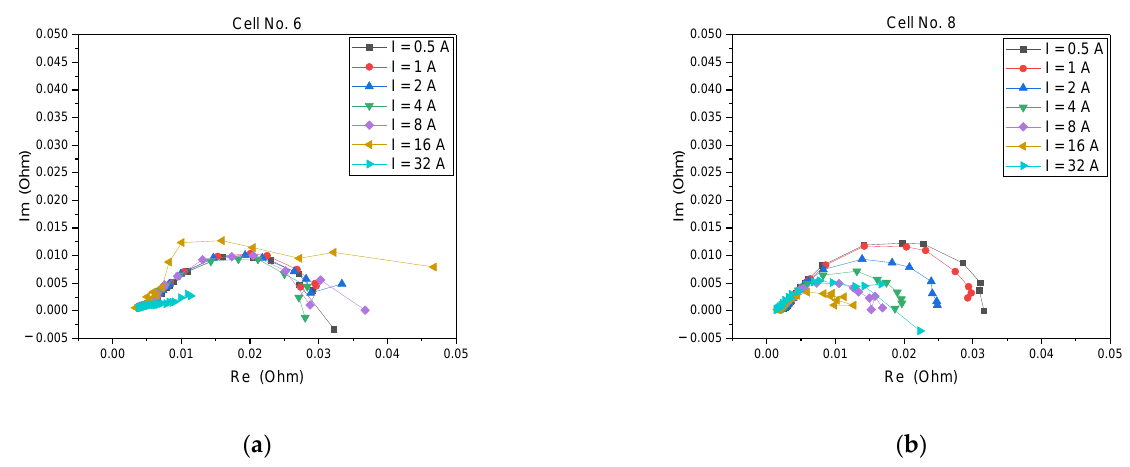
Figure 3. Impedance spectra of the power cells for different current loads I: ( a ) cell No. 6, ( b ) cell No. 8; the impedance (real Re and imaginary Im parts) measurements were recorded at frequencies from 0.3 Hz to 2.84 kHz.